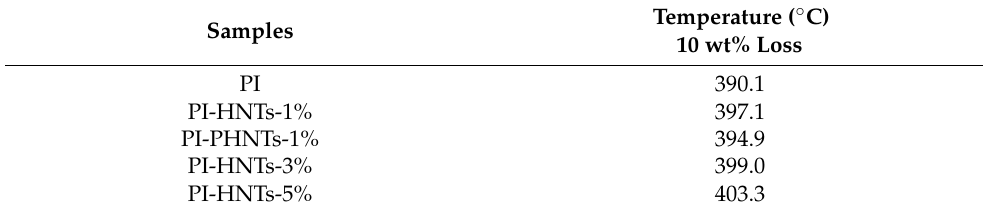
Table 3. The peak temperatures of the samples of PI, PI-HNTs-1%, PI-HNTs-3%, and PI-HNTs-5%.